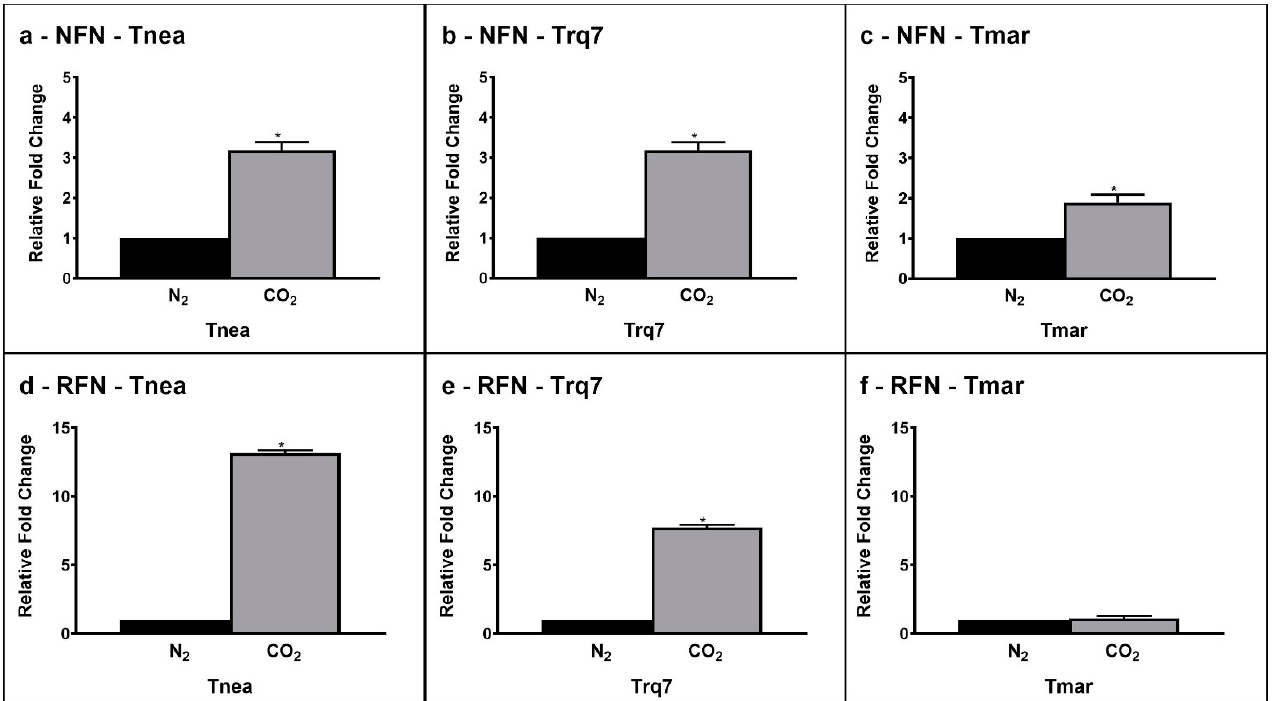
Figure 6. Gene expression levels of NFN (CTN_RS04020 ( a – c )) and RFN (CTN_RS02165 ( d – f )) under N 2 (black bars) and CO 2 (gray bars) conditions Tnea, Trq7 and Tmar . Variations are indicated as relative fold changes in CO 2 with respect to N 2 . mRNA levels were calculated relative to the expression of 16S RNA. Asterisks indicate significantly different values at p ≤ 0.05 (*).